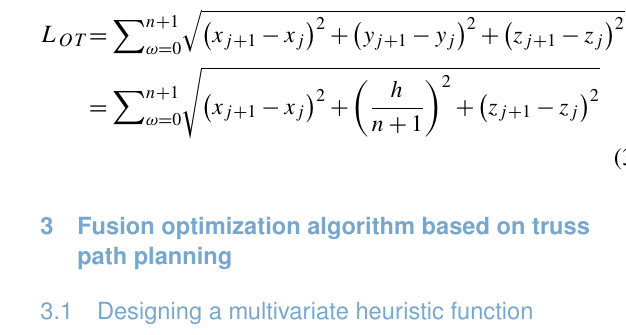
Figure 4. Truss three-dimensional